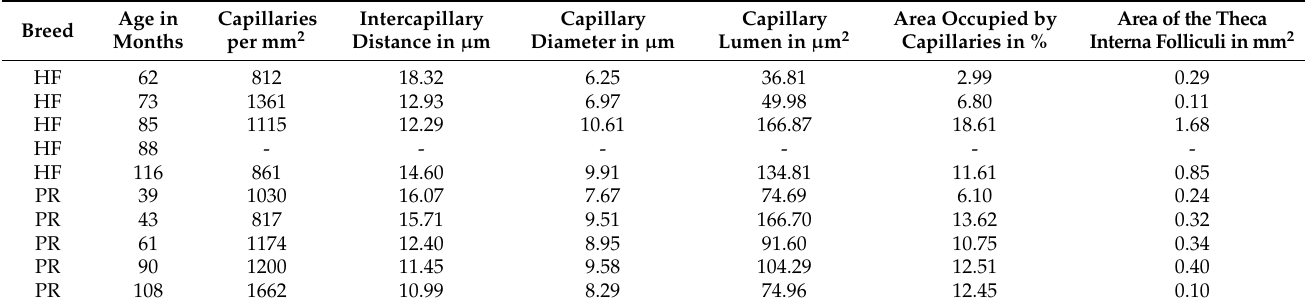
Table 1. Vascularization of the tertiary follicles in bovine ovarian tissue. HF Holstein-Friesian, PR Polish Red cow.